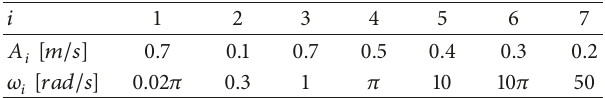
Table 2: The amplitude and frequency of wind speed components